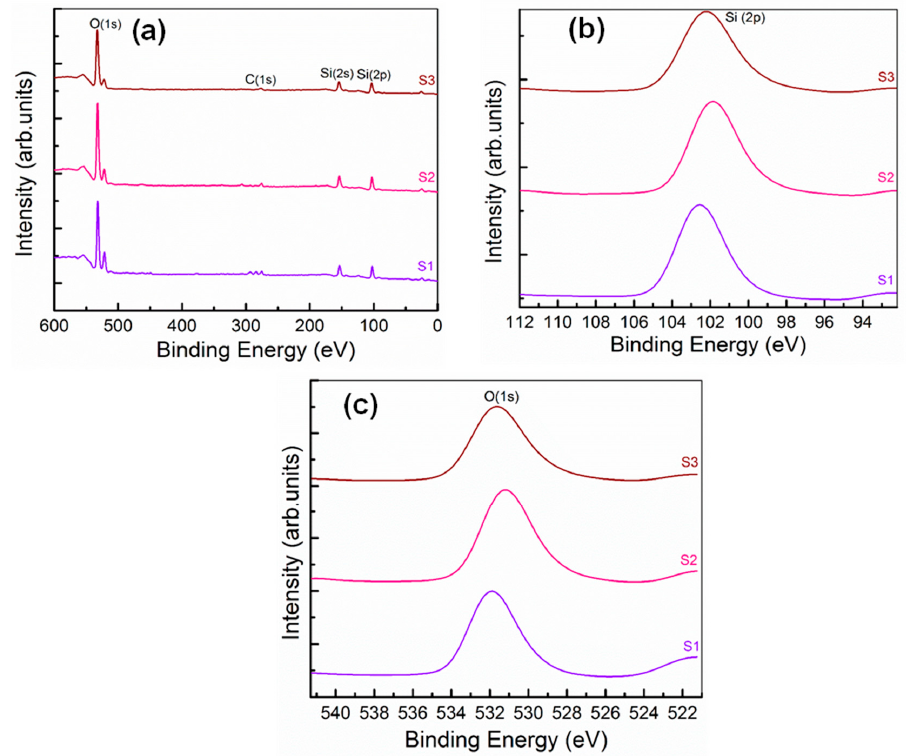
Figure 3. X-ray photoelectron spectroscopy (XPS)-spectra of S1, S2, and S3 nanopowders, ( a ) full scale spectra, ( b ) the core level spectra of Si (2p), and ( c ) the core level spectra of O (1s).